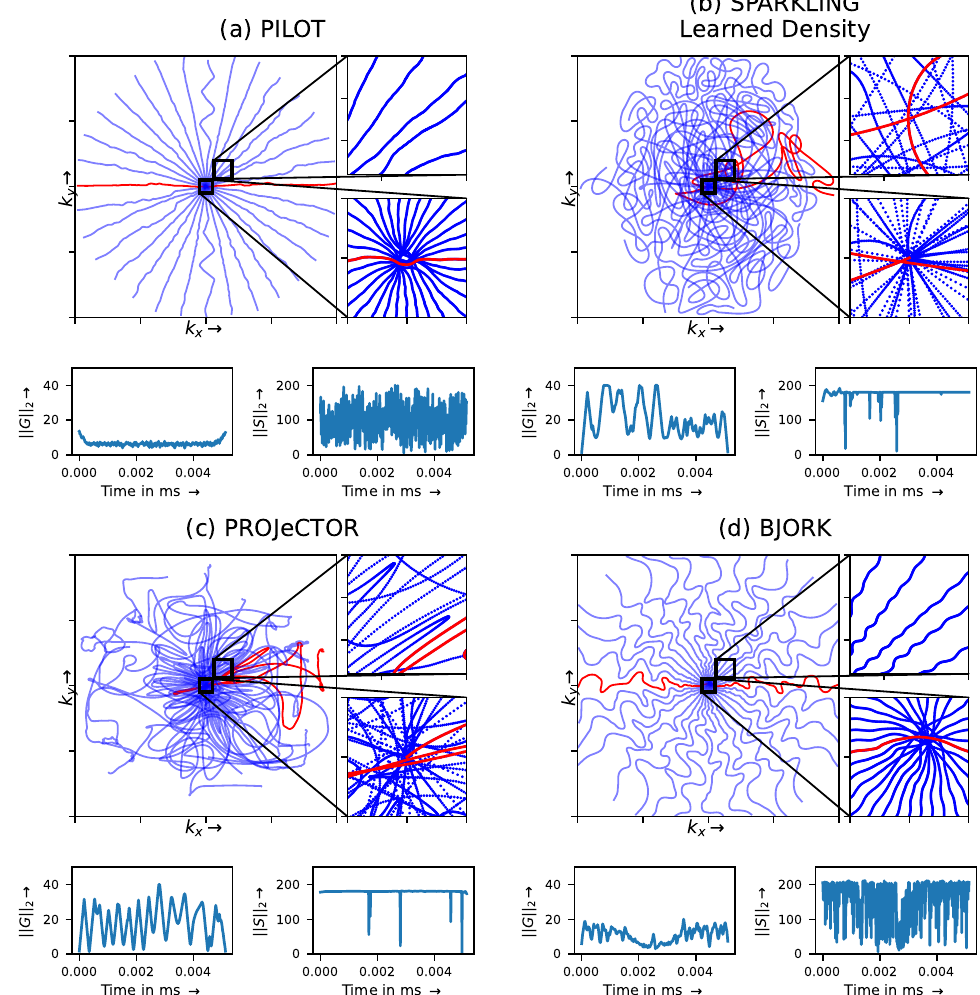
Figure 2. The optimized hardware compliant non-Cartesian k -space trajectories using ( a ) PILOT, ( b ) SPARKLING with learned density using LOUPE, ( c ) PROJeCTOR scheme, and ( d ) BJORK. The number of shots is N c = 16. The number of dwell time samples are set to match the same number of sampling points overall. Zoomed in visualizations of the center of k -space (bottom) and slightly off-center (top) are presented at the right of the corresponding trajectories. The (cid:96) 2 norm of the corresponding gradient || G || 2 (in mT/m) and slew rate || S || 2 (in T/m/s) profiles are depicted below each